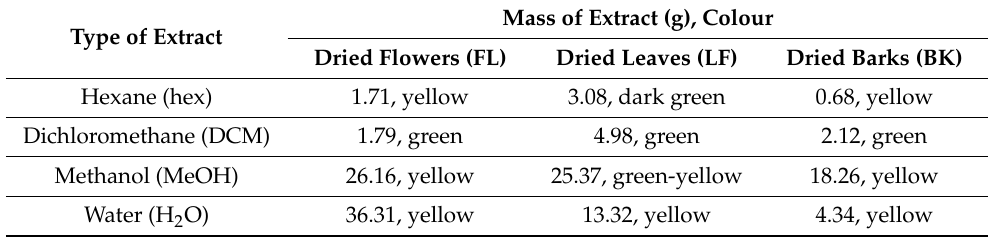
Table 1. The result of the extraction of the flowers, leaves, and barks of A. saligna . Mass of Extract (g), Colour Type of Extract Dried Flowers (FL) Dried Leaves (LF) Dried Barks (BK) Hexane (hex) 1.71, yellow Dichloromethane